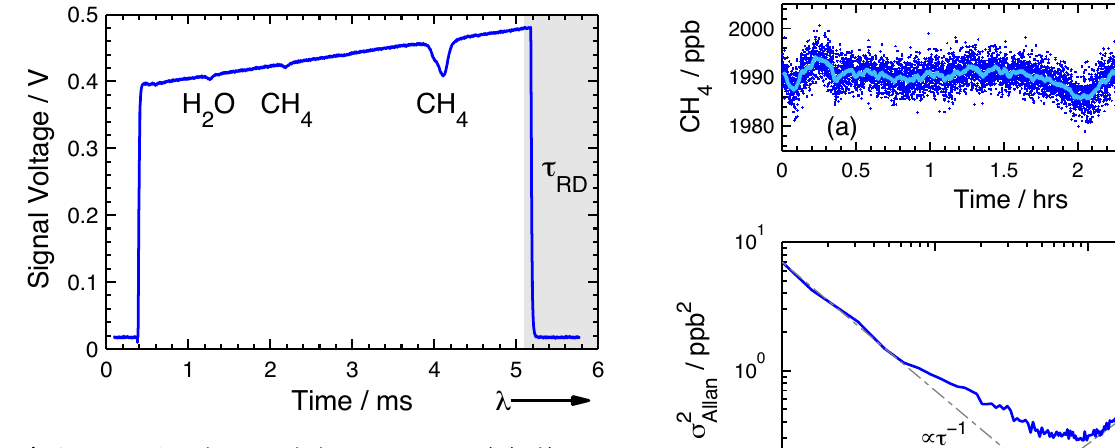
Fig. 2. OA-ICOS cavity transmission spectrum recorded with an os- cilloscope showing the CH 4 and H 2 O absorption lines probed. The shaded area indicates the time where the ringdown-time constant τ RD is determined.